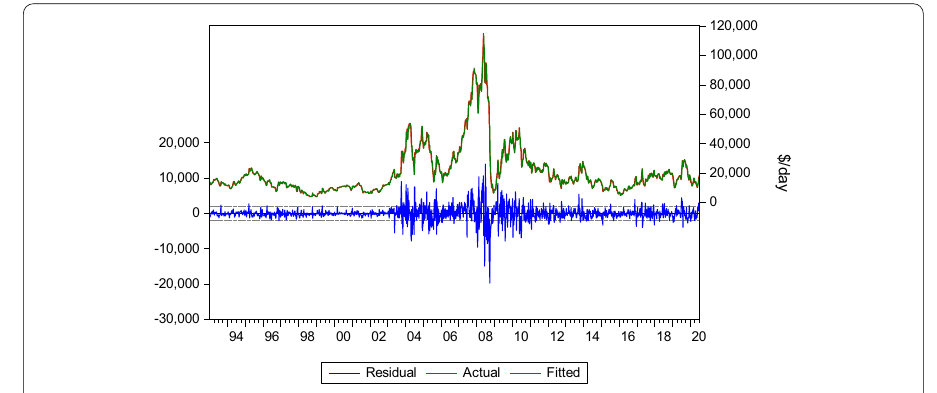
Fig. 6 Continent–Far East 72.000 dwt. Source : Elaboration by the authors